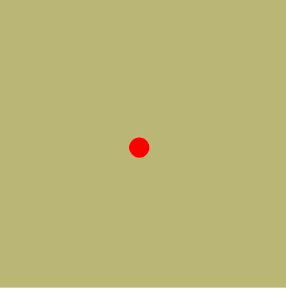
Figure 9. Schematic diagram of accessibility calculation points.